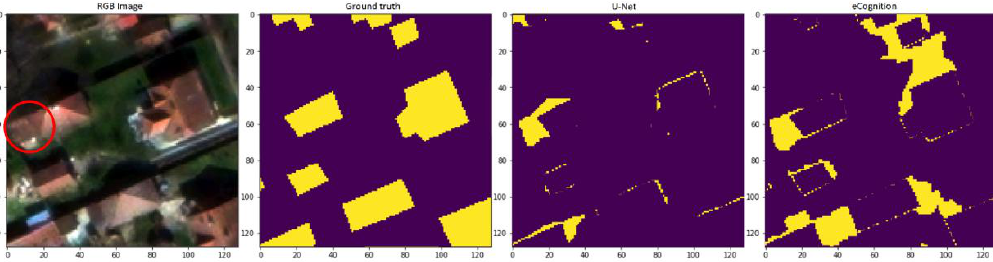
Figure 24. New identified objects.